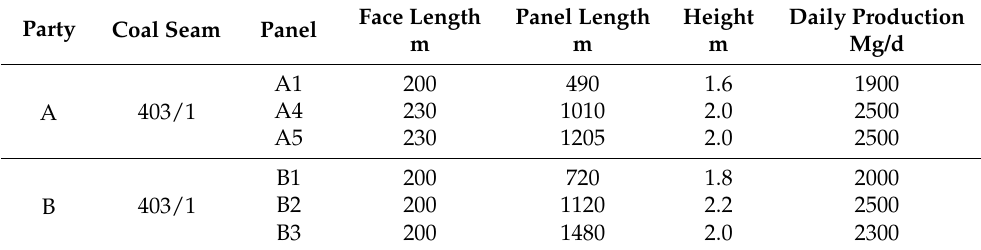
Table 4. Parameters of longwalls in parties A and B of 403/1 coal